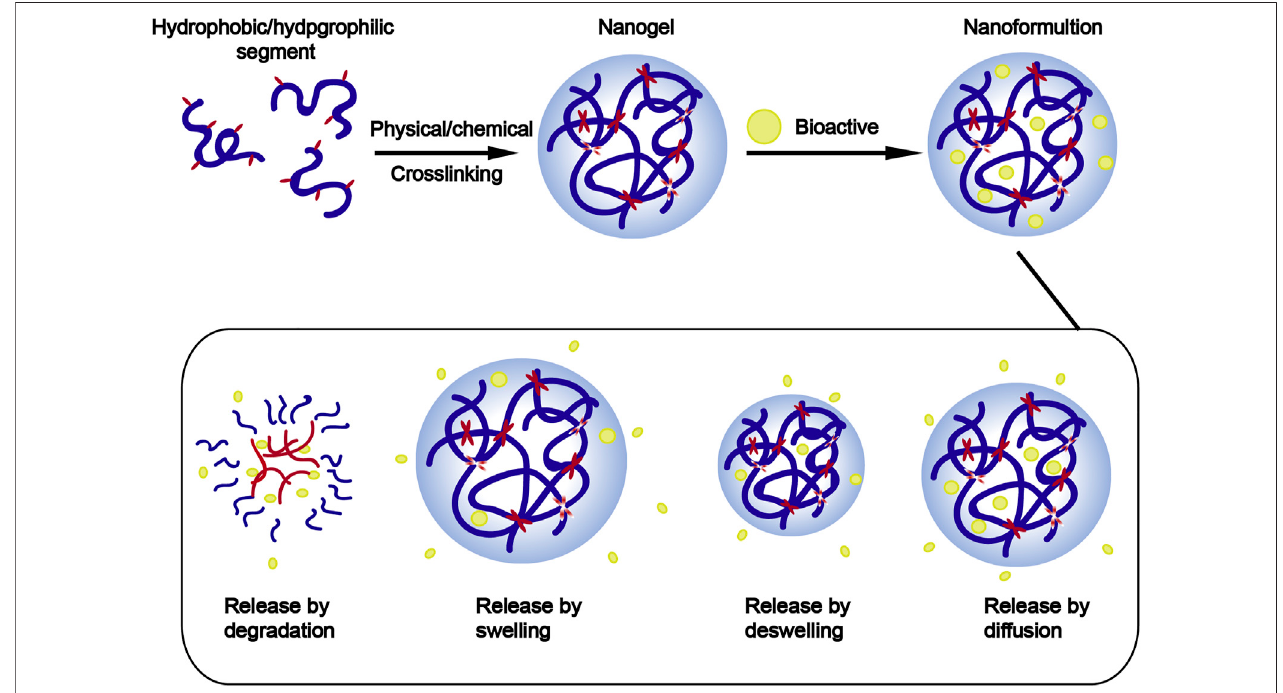
FIGURE 2 | Schematic representation of the synthesis and the release behavior of nanogels.